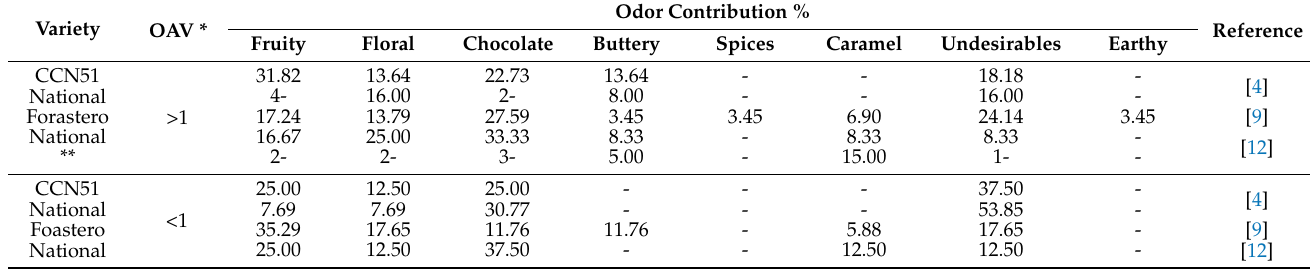
Table 5. Odor activity values of key aroma compounds in cocoa liquor.